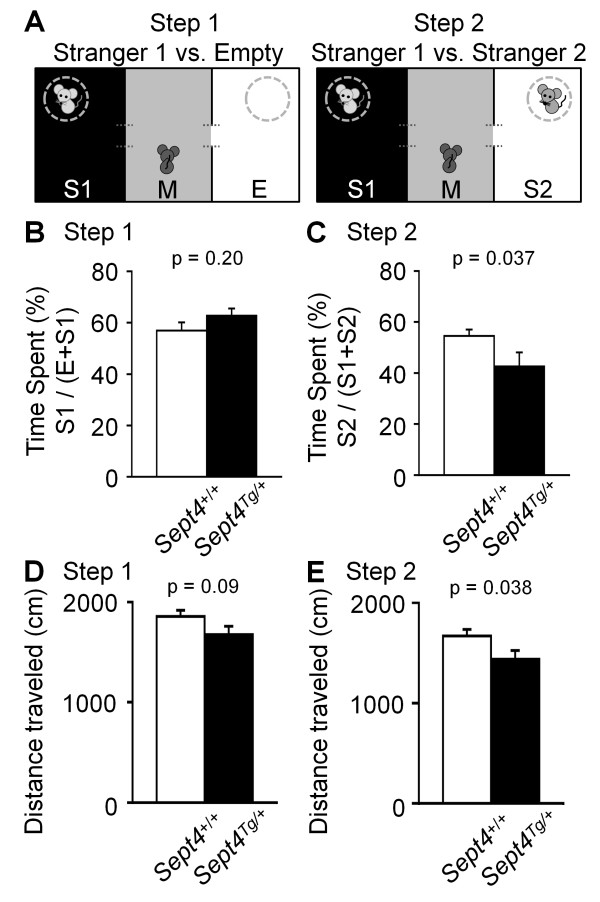
Altered social interaction pattern of Sept4Tg/+ mice. (A) Schematic diagrams of the three-chamber sociability and social novelty preference tests [18]. (Left) The sociability test setup. Each mouse was scored for the time spent in the middle habituated chamber (M), the left chamber containing an unfamiliar C57BL/6J mouse (Stranger 1, S1) in a wire cage, or the right chamber with an empty wire cage (E). (Right) The social novelty preference test following the sociability test uses the same apparatus, except for a novel unfamiliar C57BL/6J mouse (Stranger 2, S2) caged in the right chamber in addition to the now-familiar C57BL/6J mouse (Stranger 1, S1) remaining in the left cage/chamber. (B, D) There was no difference in the sociability indices (S1 over E) between the genotypes. [(B) F1,32 = 1.68, p = 0.20, (D) F1,32 = 4.75, p = 0. 037]. (C, E) In the social novelty preference test (Step2) after the sociability test (Step1), Sept4Tg/+ mice exhibited significantly less preference for S2 over S1 than Sept4+/+ mice, indicative of their reduced curiosity in the novel social stimuli and/or augmented persistence to the familiar social stimuli (n = 20, 14). [(C) F1,32 = 3.06, p = 0.09, (E) F1,32 = 4.69, p = 0. 038].